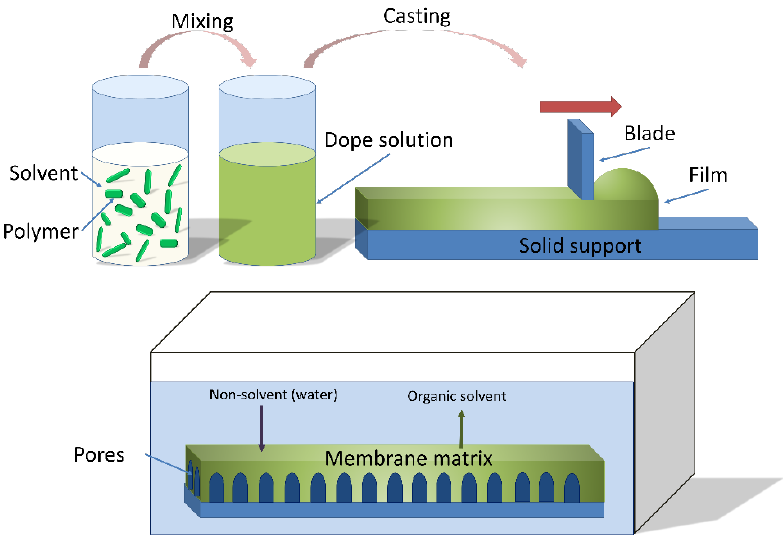
Figure 2. Non-solvent induced phase separation casting process (NIPS). Reprinted from [22], Copyright 2018 MDPI.